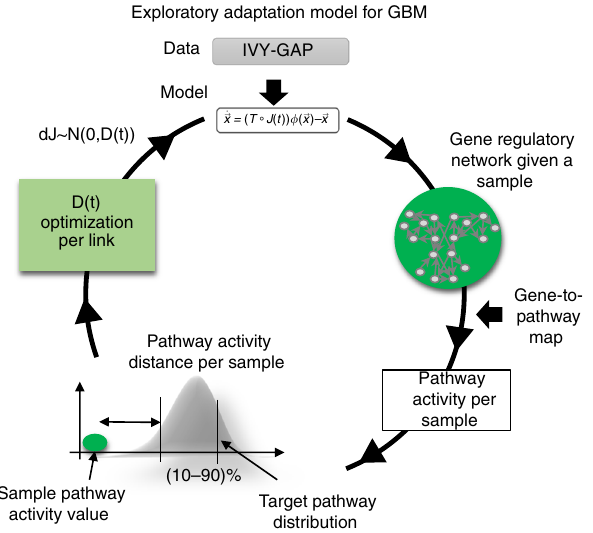
Fig. 2 Flow chart of single-sample dynamics model. At every time step t , the model performs the following steps: (1) the vector of gene expression ( x ( t )) is updated based using the gene regulatory network, with edges weighted by correlations between the expression of the nodes genes;